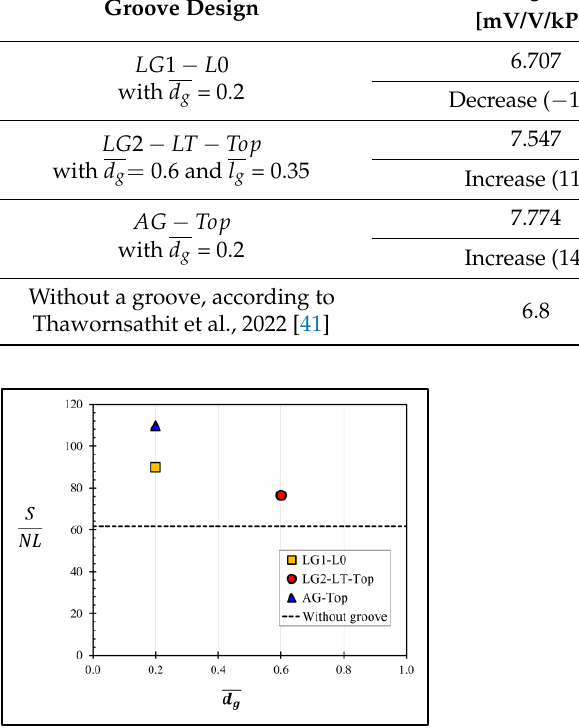
(cid:16) (cid:17) ) of sensors with three optimal groove de- S of sensors with three optimal groove 𝑁𝐿 NL